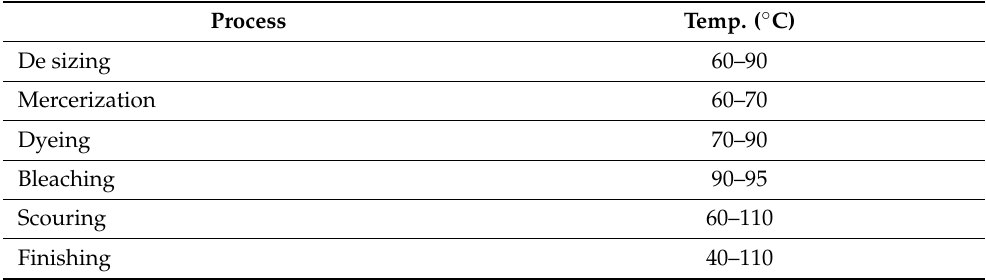
Table 5. Process in a textile factory